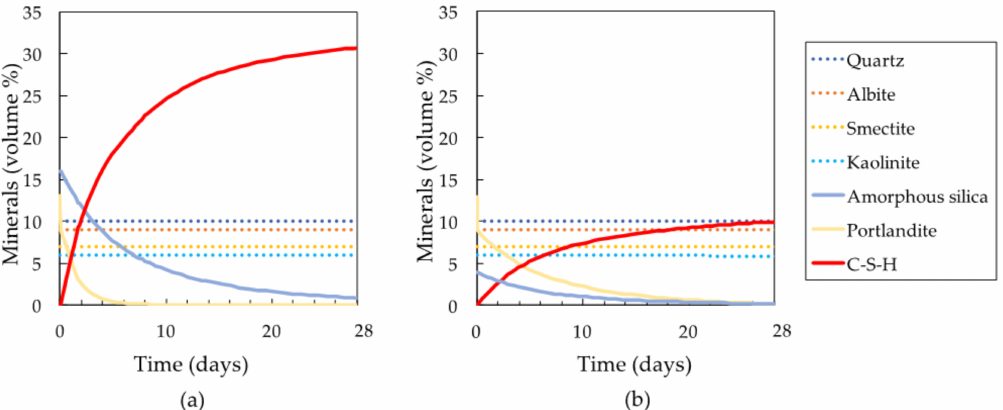
Figure 15. Calculation of C-S-H formation by simulated steel slag-dredged soil interactions in: ( a ) Run 1, with 16 vol % of amorphous silica as the reactant and ( b ) Run 2, with 4 vol % of amorphous silica as the